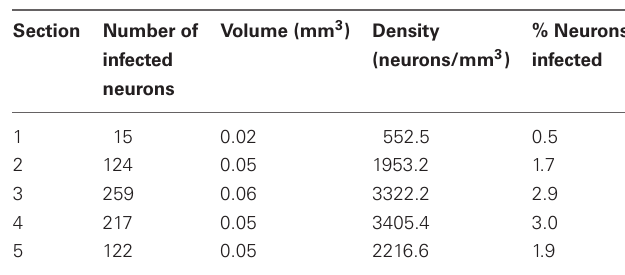
Table 3 | Summary of GFP expression for the second injection site in monkey